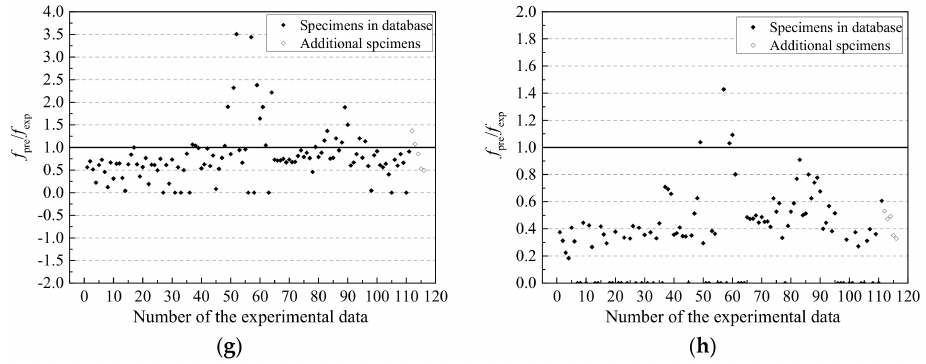
Figure 15. Comparison of the ratio between the experimental and predicted results using different methods: (a) ANN; (b) SVR; (c) CSA A23.3-14; ( d ) BS 8100-1:1997; ( e ) AS 3600-2009; ( f ) DIN 1045-1:2008; ( g ) fib Model Code 2010 and EN 1992-1-1:2004; ( h ) ACI